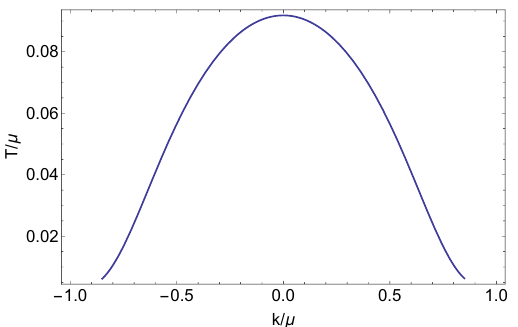
Figure 1 . Plot of the temperature T at which a zero more for (cid:30) appears as a function of the wavelength k